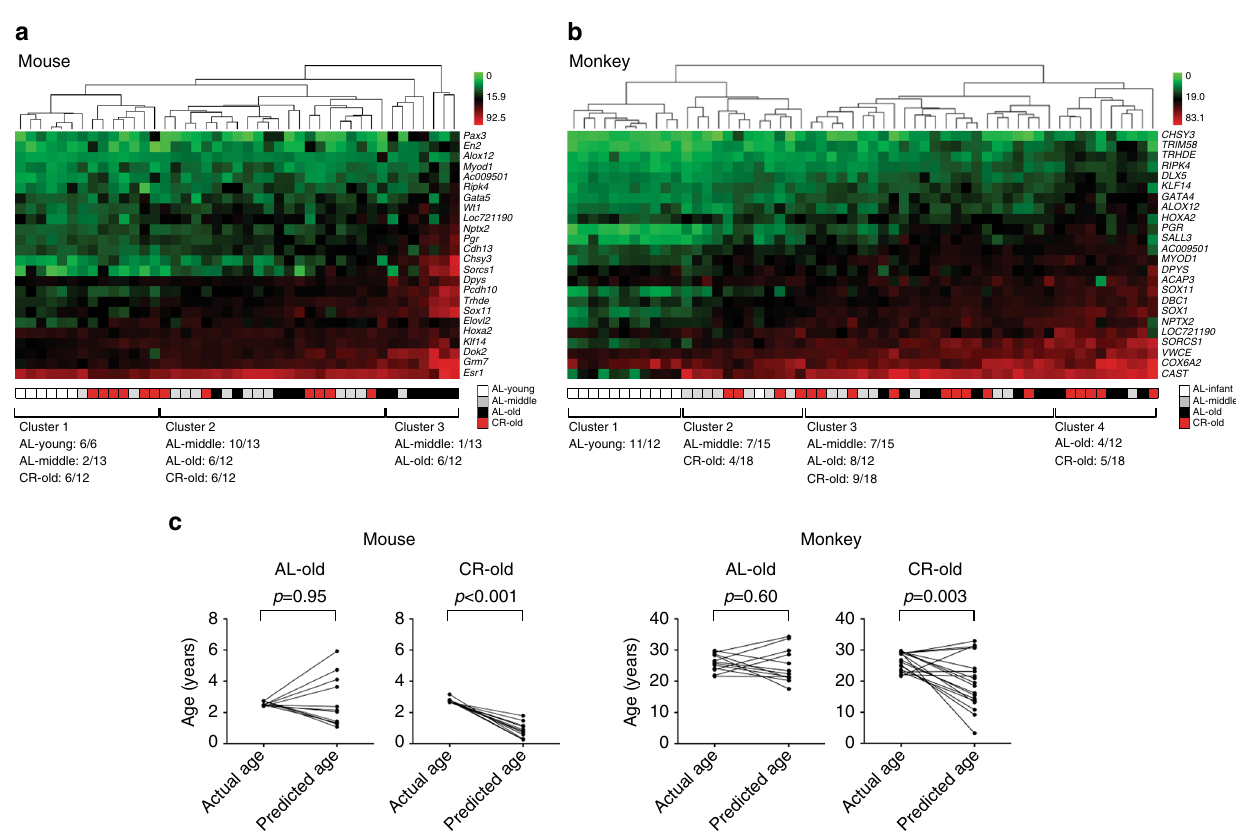
Fig. 5 CR effects on aging drift detected by bisul fi te pyrosequencing assays. a , b Unsupervised hierarchical clustering analysis of the loci assayed by bisul fi te pyrosequencing showing aging methylation drift and the effect of CR in whole blood in mice and monkeys. The green to red color scale indicates the methylation percentage. The color codes of caloric status and age are shown on the bottom-right . c Differences between the age predicted based on methylation and the chronological age. Predicted age was calculated using the mixed linear model and data from bisul fi te pyrosequencing assays. Each pair of dots connected by a line represents the difference between predicted age and chronological age in each individual. Paired t -test was used for p -value genes was 26 ± 2% in AL old mice and 17 ± 0.7% in CR old mice ( p = 0.003, unpaired t -test with Welch ’ s correction). We found a strong negative correlation (Spearman r = – 0.92, p < 0.001, two-